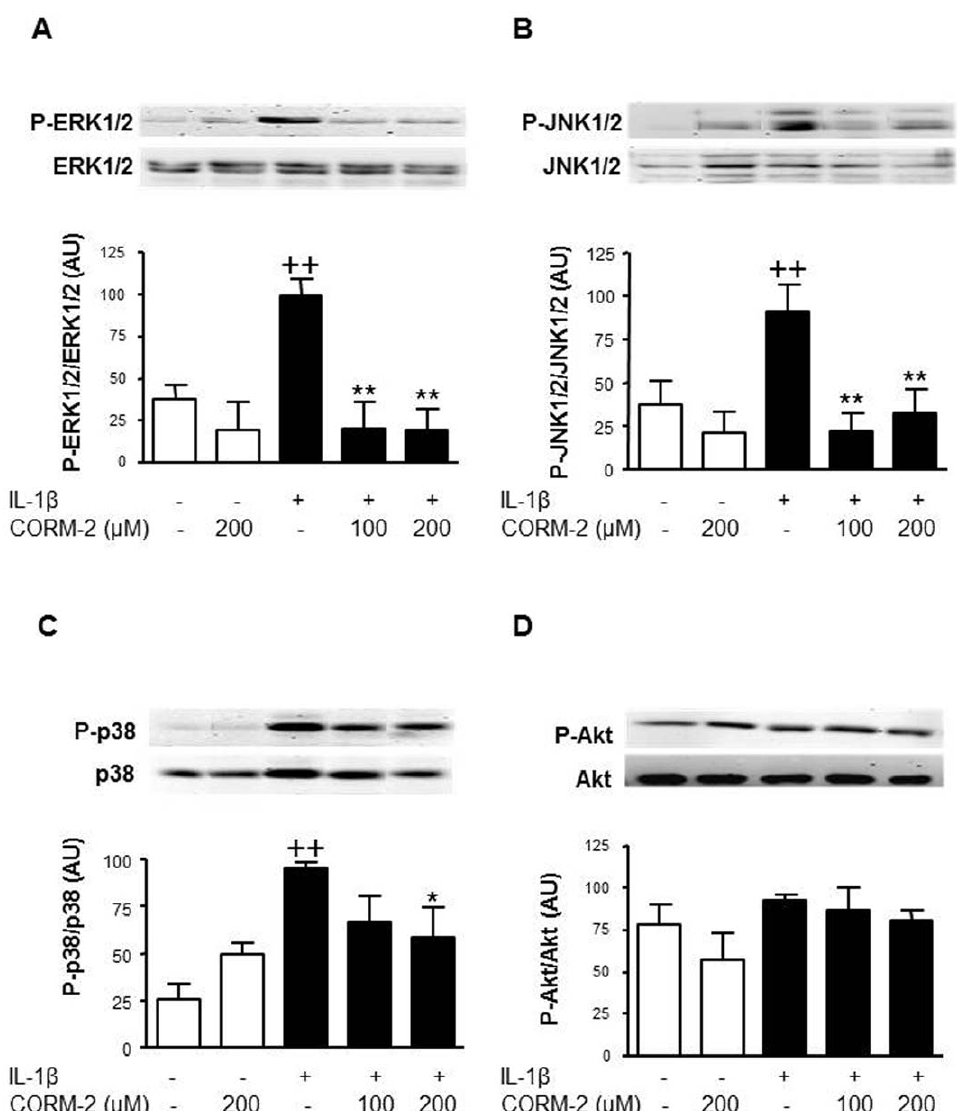
Figure 9. Effect of CORM-2 and IL-1 b on Akt and MAPK phosphorylation in OA synoviocytes. Cells were stimulated with IL-1 b (10 ng/ml) for 5 min in the presence or absence of CORM-2 (100, 200 m M). Protein expression was determined in cell lysates by Western blotting using specific antibodies against phosphorylated or total proteins. Relative expression of phosphorylated and total protein bands was calculated after densitometric analysis. AU=arbitrary units. Data are expressed as mean 6 S.E.M. (samples from 3 patients). ++ P , 0.01 with respect to nonstimulated cells. * P , 0.05, ** P , 0.01 with respect to IL-1 b .